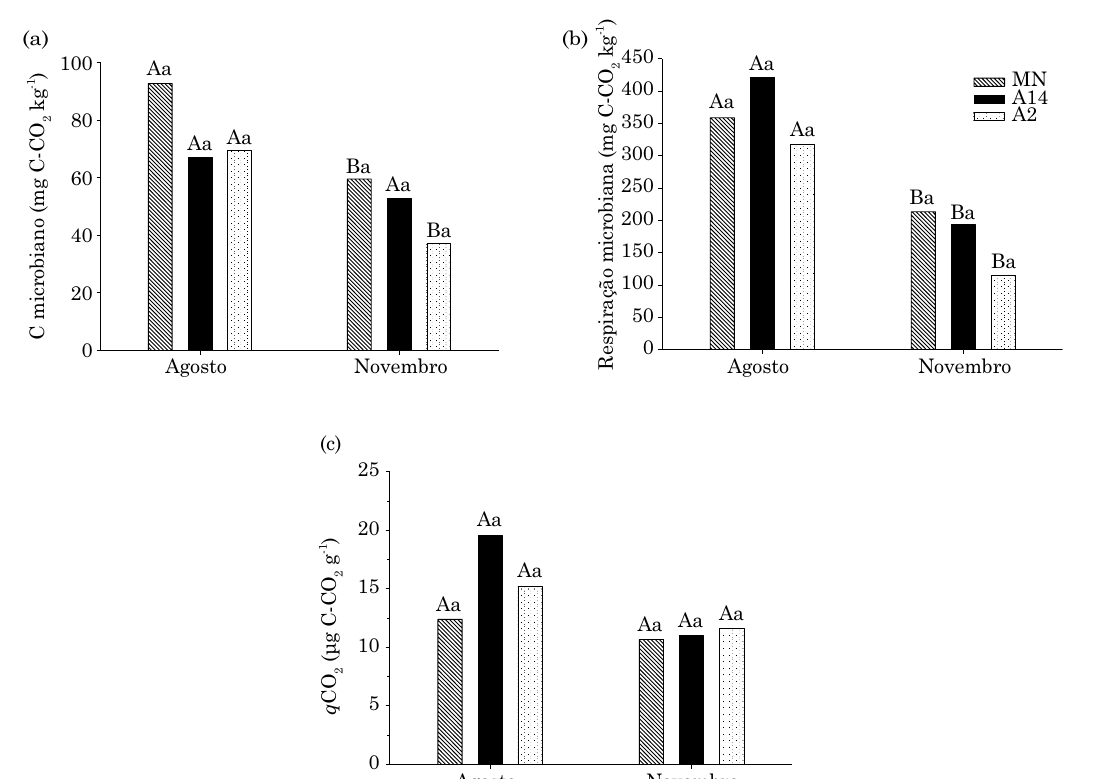
Figura 2. Carbono microbiano (a), respiração microbiana acumulada em 14 dias (b) e quociente metabólico ( q co 2 ) (c) em amostras de solo das áreas Mn (Mata nativa), a2 (pastagem de azevém + tifton, com uso de dejetos suínos há dois anos) e a14 (pastagem de azevém + tifton, com uso de dejetos suínos há 14 anos), em duas épocas de coleta (agosto e novembro). Médias seguidas pela mesma letra minúscula, entre tratamentos, e maiúscula, entre épocas, não diferem estatisticamente entre si pelo teste de tukey a 5